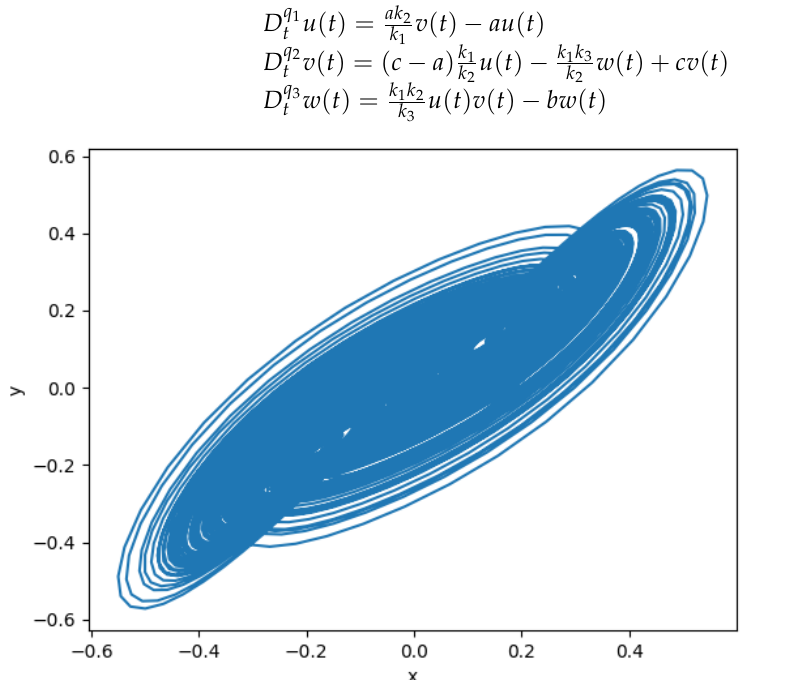
Figure 3. Chen attractor after scaling to allow CMOS design.